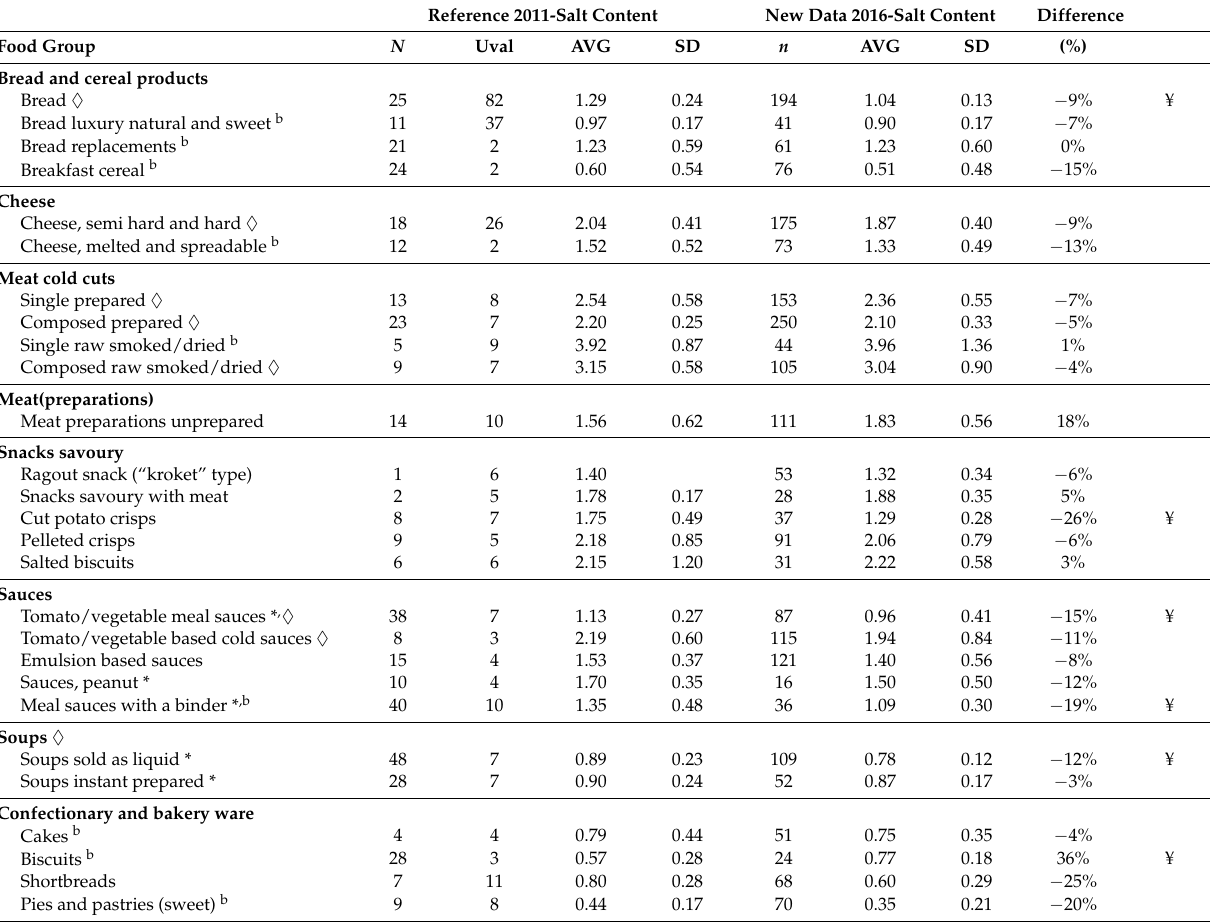
Table 1. Salt contents of foods (g/100 g) in 2016 compared to 2011, main food